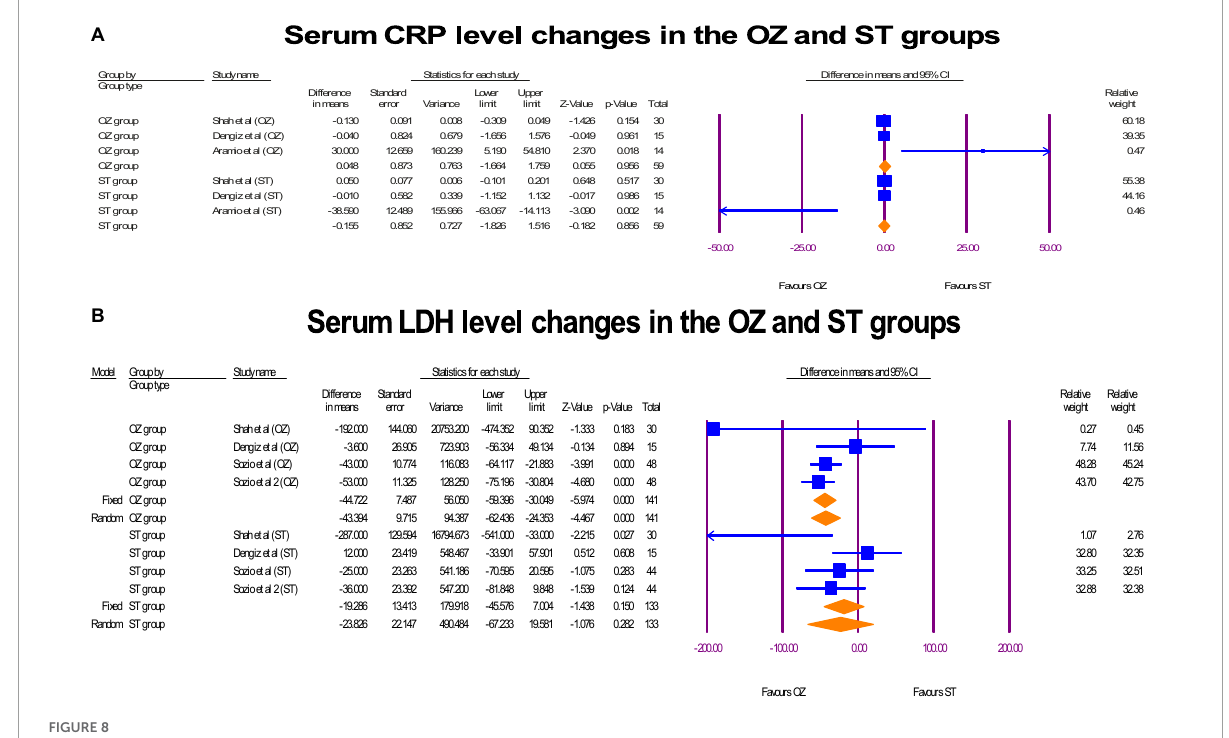
FIGURE8 The forest plots of inflammatory markers changes before and after of interventions in the both arms.